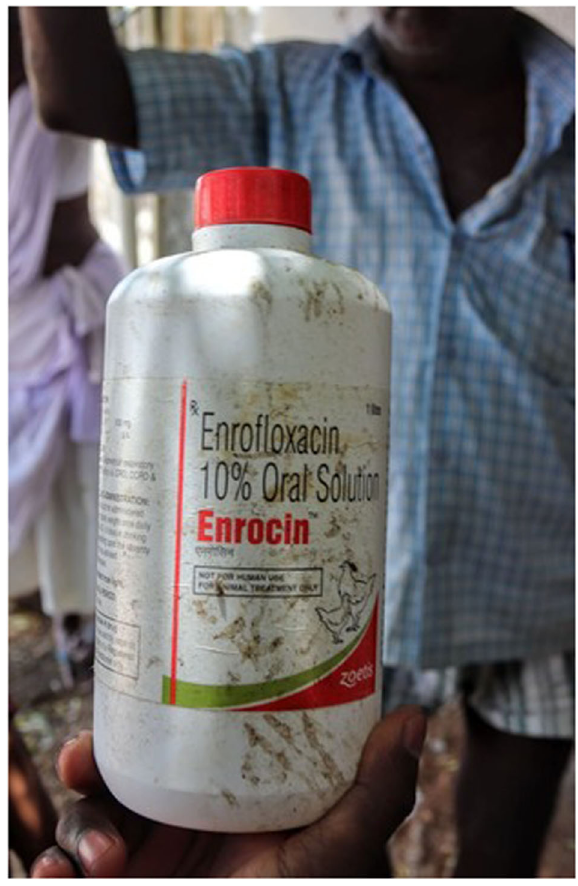
Fig. 5 Usage of Antibiotics on broiler farms. A farmer showing a bottle of Enro fl oxacin being used on his broiler